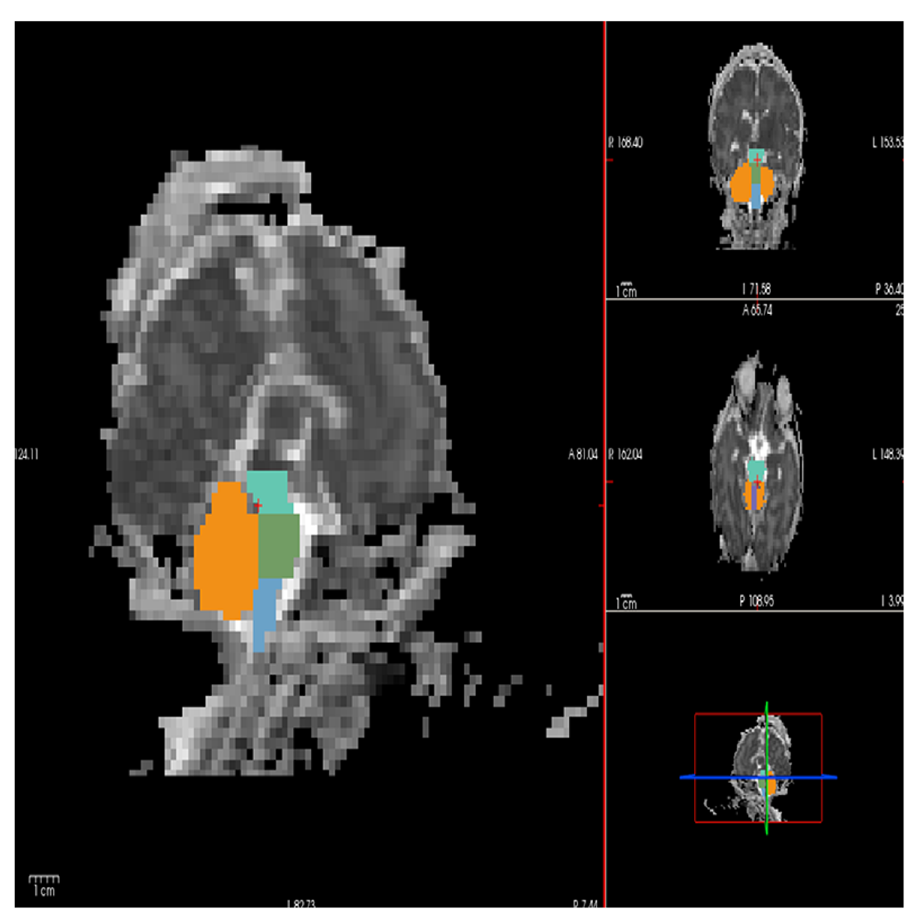
Fig 1. ROI locations on an ADC map within free view. A semiautomated segmentingtool within the FreeSurfer software package.ROIs were drawn for the hemispheres of the cerebellum(orange), vermis (violet), midbrain (turquoise-blue), pons (green)and medulla(light blue). Left sagittal view, right from top to bottom, coronal, axial and triplaneimage.